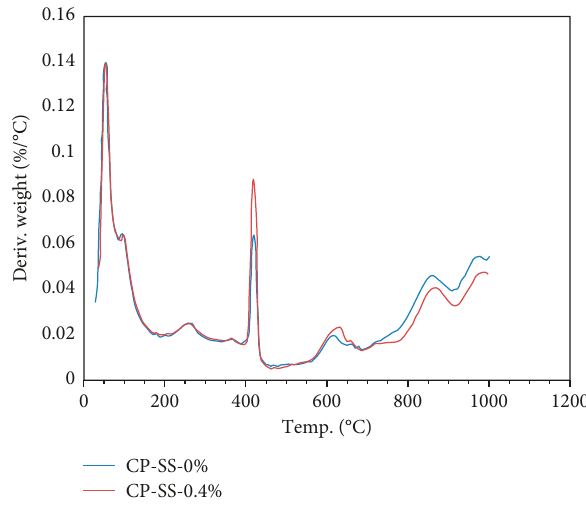
Figure 4: TG (a)/DTG (b) diagrams for FA-cemented paste of FA-CTB cured for 28